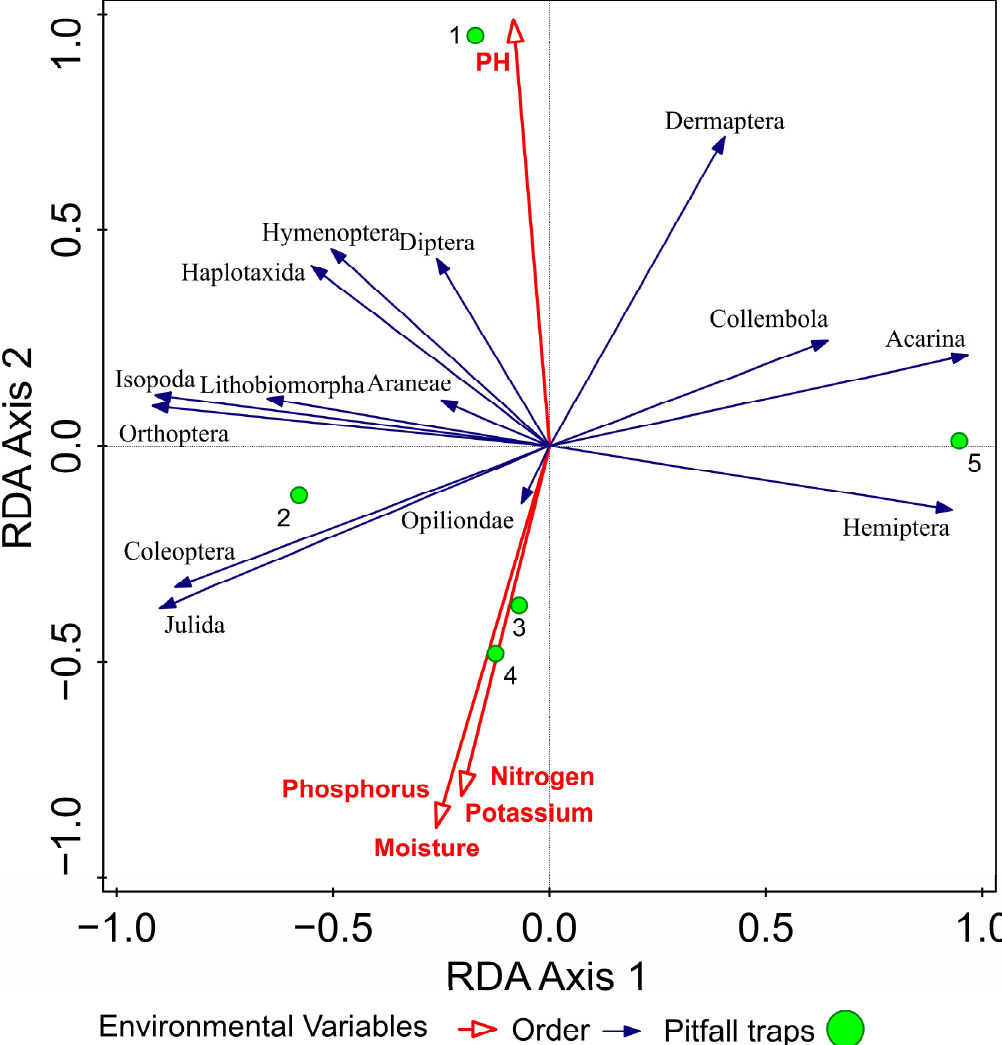
Figure 3. RDA (redundancy analysis) analysis of arthropods with respect to environmental varia- bles.